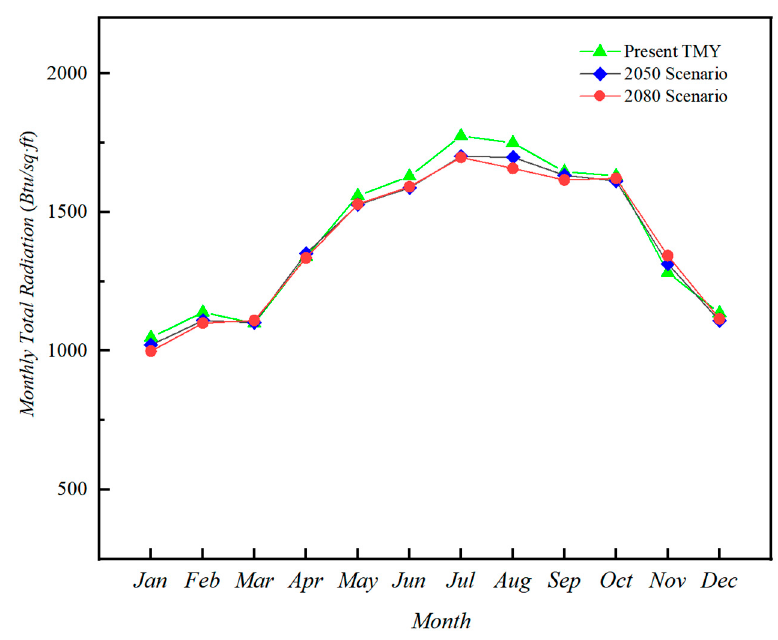
Figure 11. Total monthly radiations of present TMY and predicted future scenarios (2050 and 2080).